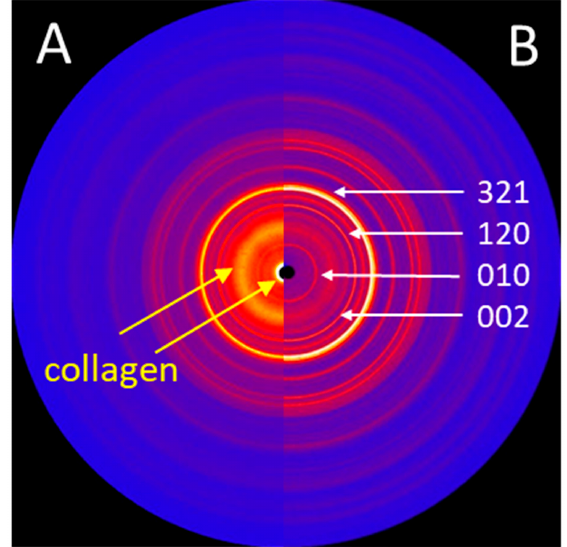
Figure 6. ( A ) 2D X-ray diffraction image (IPDS-II, Mo-radiation) of the trabecular bone structures, showing structural features of both HA and collagen. ( B ) 2D X-ray diffraction image of the HA powder obtained from the surface of a new stem, showing sharp diffraction peaks. The main diffraction peaks (hkl) of the HA crystallographic phase are indicated.